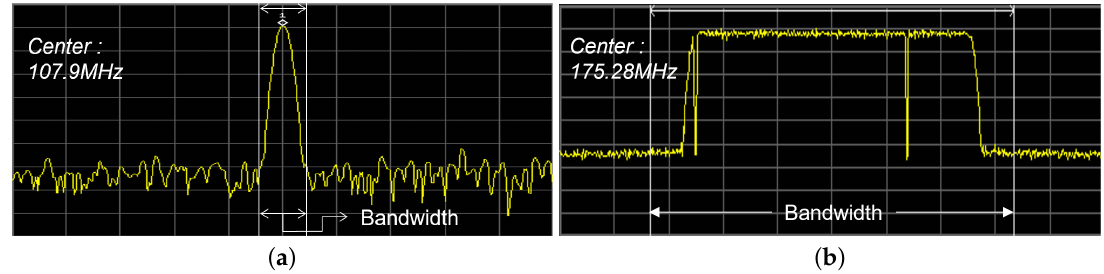
Figure 13. Simulation result of single-channel FM and DMB signal. ( a ) FM signal with a center frequency of 107.9 MHz and bandwidth = 0.15 MHz. ( b ) DMB signal with a center frequency of 175.28 MHz and bandwidth = 1.536 MHz.